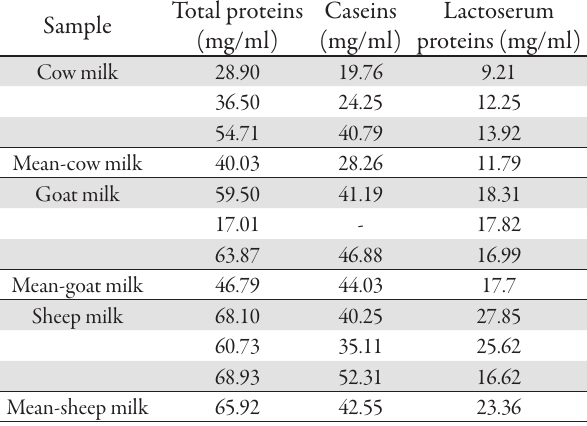
Tab. 1. The concentration (mg/ml milk) of total proteins, caseins, whey proteins in degreased milk of cow, goat and